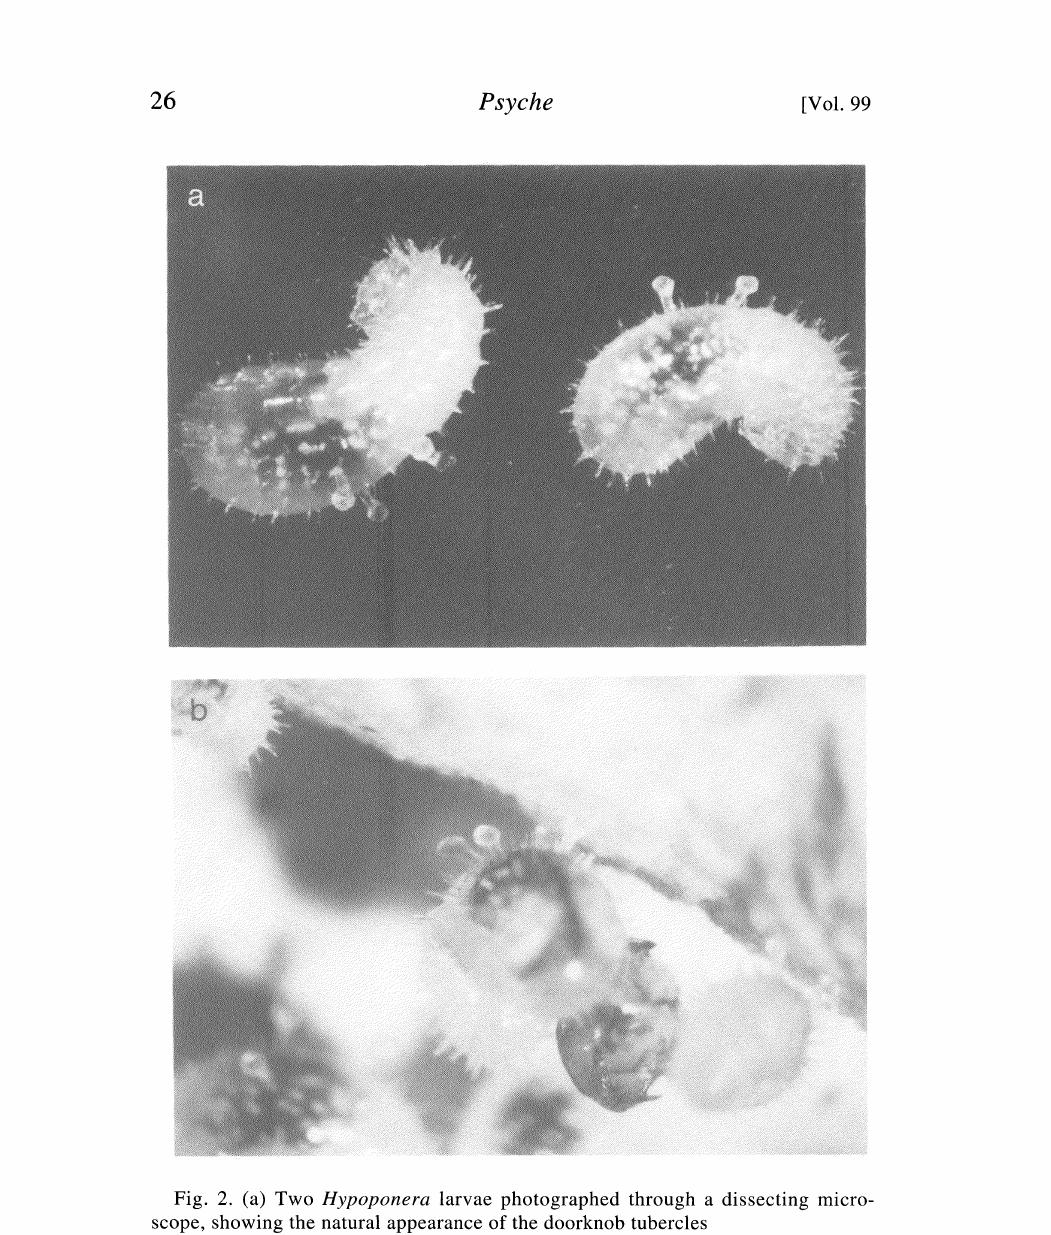
Fig. 2. (a) Two Hypoponera larvae photographed through a dissecting micro- scope, showing the natural appearance of the doorknob tubercles (b) Larvae attached to the walls of the nest chambers. Both larvae are eating on a piece of prey which was placed there by